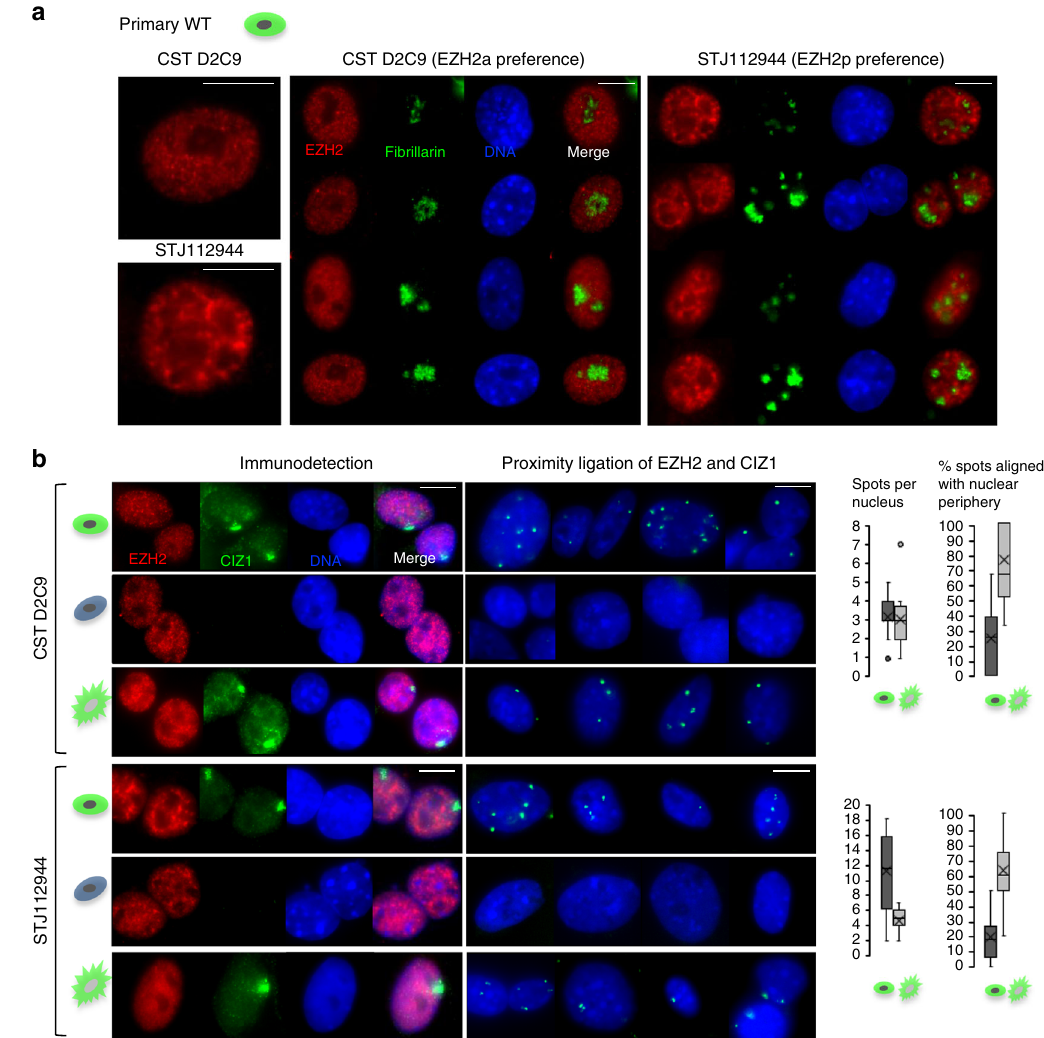
Fig. 7 Differential isoform detection with EZH2 antibodies. a Immuno-detection of EZH2 with two different EZH2 antibodies (CSTD2C9 and STJ112944), and of the nucleolar protein fi brillarin in primary mouse embryonic fi broblasts (14.4 p3) showing distinct EZH2 staining patterns, and peri-nucleolar enrichment with STJ112944. Scale bar is 10 microns. b Immuno-detection (left) and proximity ligation (middle) of two different EZH2 antibodies (CSTD2C9 and STJ112944) with CIZ1 (hC221) in primary WT (14.4 p3), primary CIZ1 null (13.15 p2) and culture adapted WT (13.8 p23) embryonic fi broblasts. For EZH2 image intensity is differentially adjusted to reveal pattern rather than relative signal intensity. Scale bar is 10 microns. Right, quanti fi cation of proximity ligation assay showing the number of spots per nucleus ( n = 20) and the percentage of spots aligned with the nuclear periphery for the primary and culture adapted WT cells, for both EZH2 antibodies. X represents the mean, the mid-line shows the median, the top and bottom line of the box the 3rd and 1st quartiles, and the whiskers the minimum and maximum values, excluding outliers (points, greater than 1.5 times the interquartile